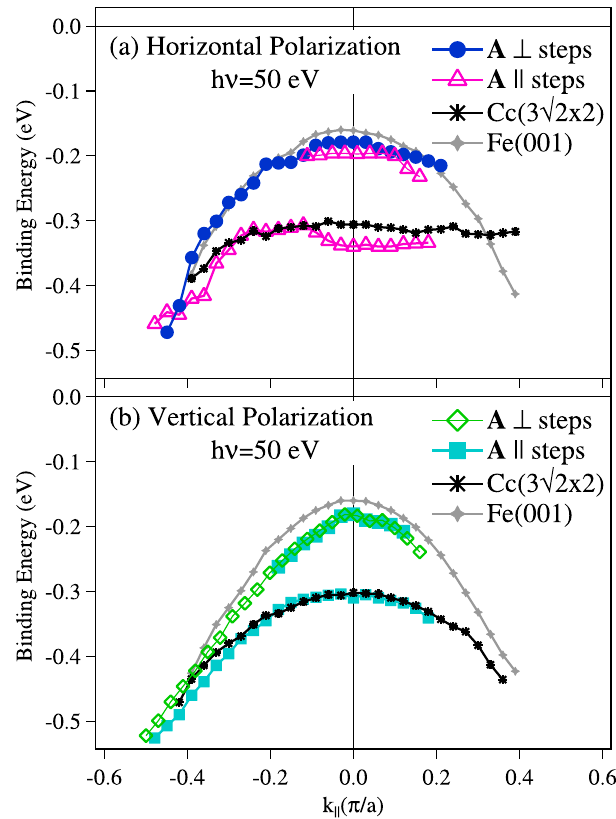
Figure 5. Dispersion of the electronic SS with k || measured for the two polarizations and equivalent geometries of Fig. 3 plotted together with the dispersion measured for a flat clean Fe(0 0 1) surface (gray cross-marked line) and the C-c(3 √ 2 × √ 2):Fe(0 0 1) (black start-marked line). The state close to the Fermi level in the stepped surface exhibits the same dispersion as that of clean Fe(0 0 1), the other disperses as the SS of the C-c(3 √ 2 × √ 2) reconstructed surface. The latter state is only seen when A is parallel to the step edges indicating that it is confined on the terraces. The intensity of the Fe-like is enhanced when A is perpendicular, suggesting that the state is more localized at the step